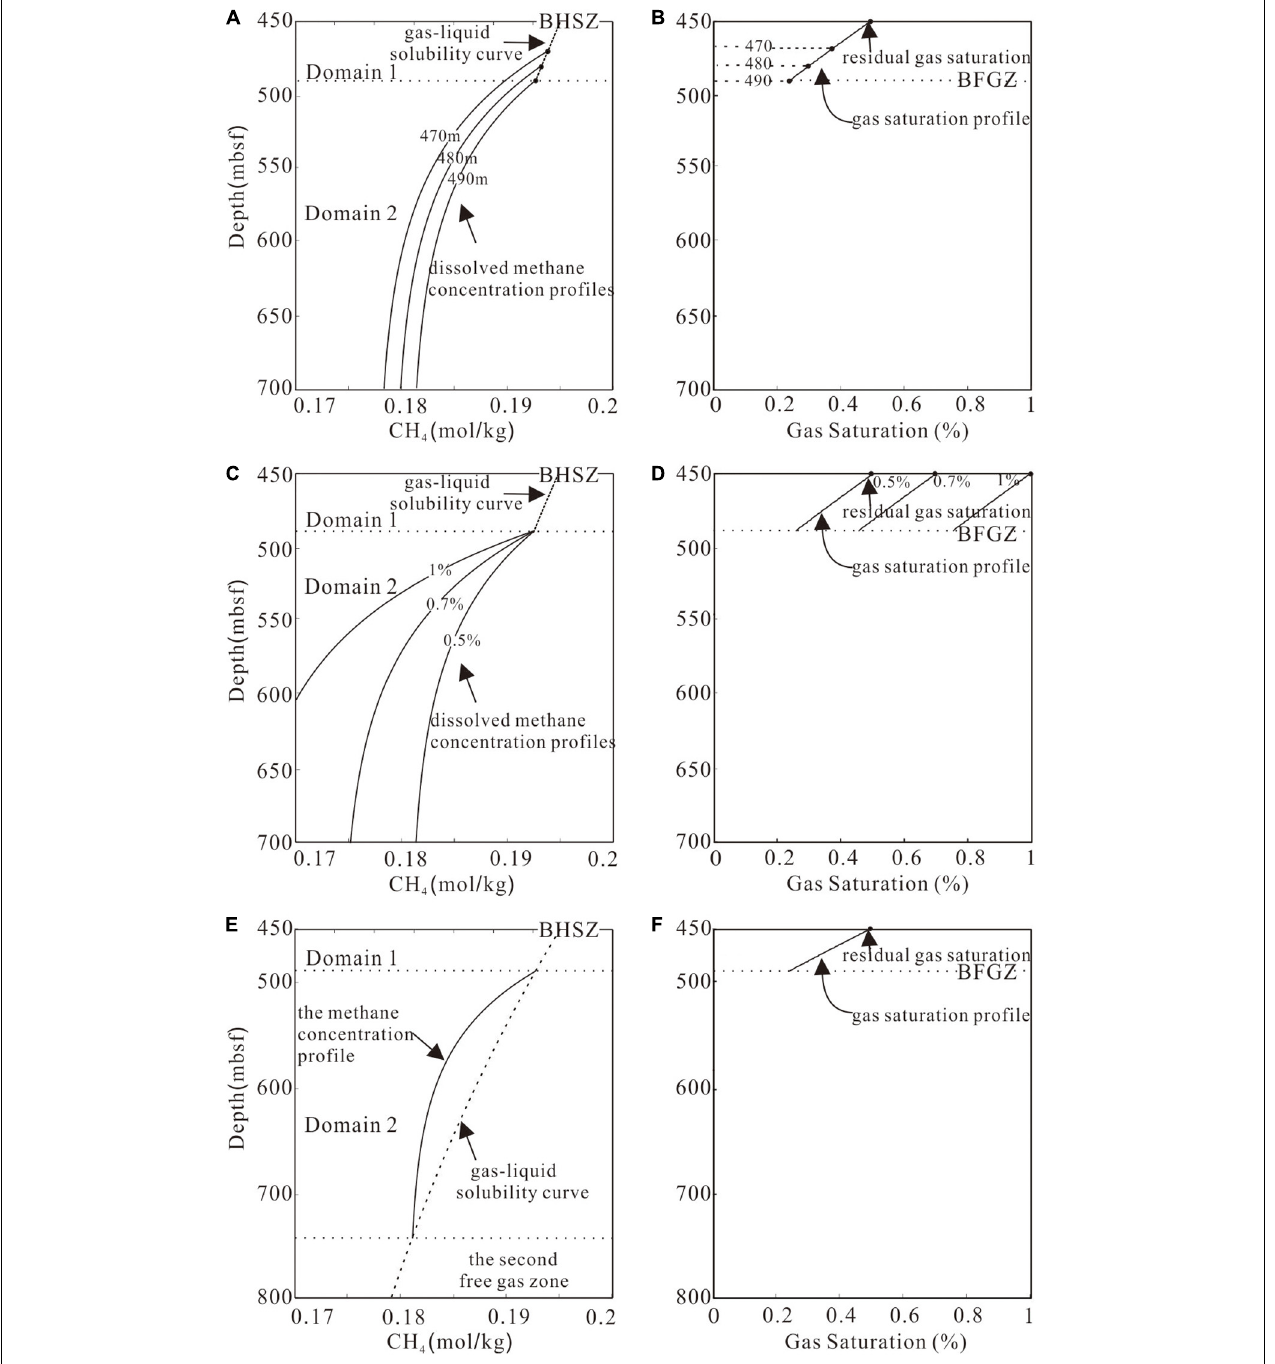
FIGURE 3 | (A) Black solid dots in Domain 1 correspond to BFGZ depth of 470, 480, and 490 mbsf, respectively. Dashed line in Domain 1 depicts the methane gas–liquid solubility curve. Three different FGZ thicknesses correspond to three methane concentration profiles, which indicate different values of methane fluxes from depth. (B) Methane gas saturation profiles according to the same residual gas saturation but different BFGZ depths. (C) Different dissolved methane fluxes from deep are represented by three lines with different slopes in Domain 2, corresponding to three distinct residual gas saturations of 0.5, 0.7, and 1%, respectively. (D) Three gas bubble profiles based on different residual gas saturations but the same BFGZ depth. (E) The dissolved methane concentration in Domain 2 is computed through the deep dissolved methane flux at Site 995 (Equation 10). The methane concentration is lower than the gas-liquid solubility in Domain 2. The deep methane flux satisfies a second gas interval occurs, which begins at approximately 740 mbsf. (F) Gas bubbles saturation profile at Blake Ridge Site 995.